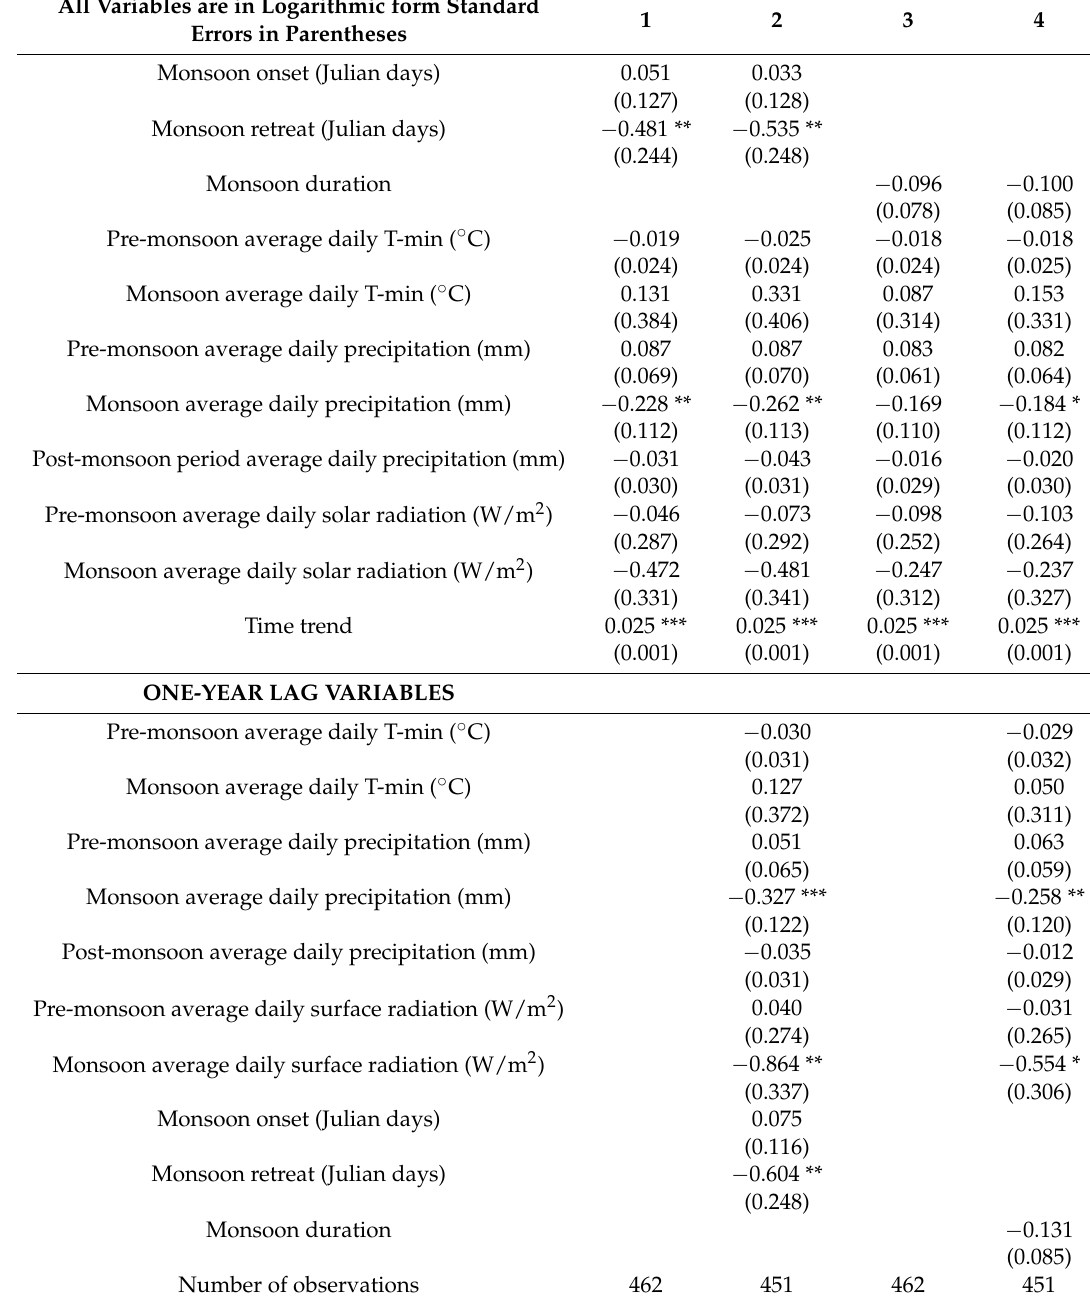
Table 3. Regression results, all with fixed effects and annual time